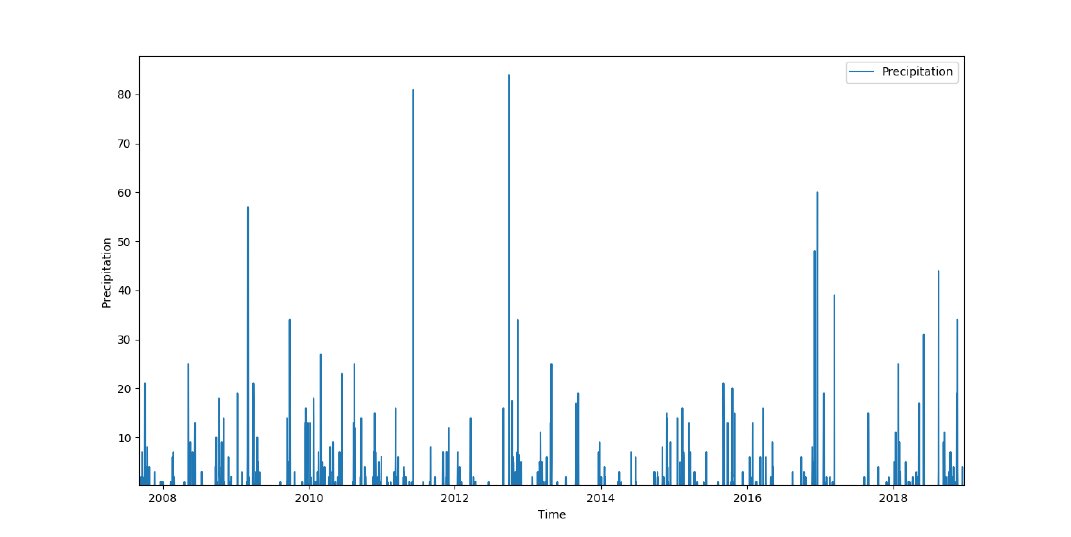
Figure 3. Rain event between 2009 and 2019 in the station of Rambla de